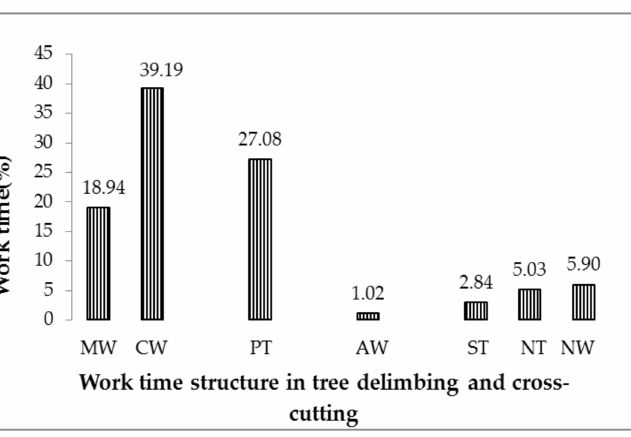
Figure 1. Work time structure in primary processing of felled trees in felling areas: MW—main work time; CW—complementary work time; PT—preparatory time; AW—ancillary work time; ST—service time; NT—non-work time; NW—non-workplace